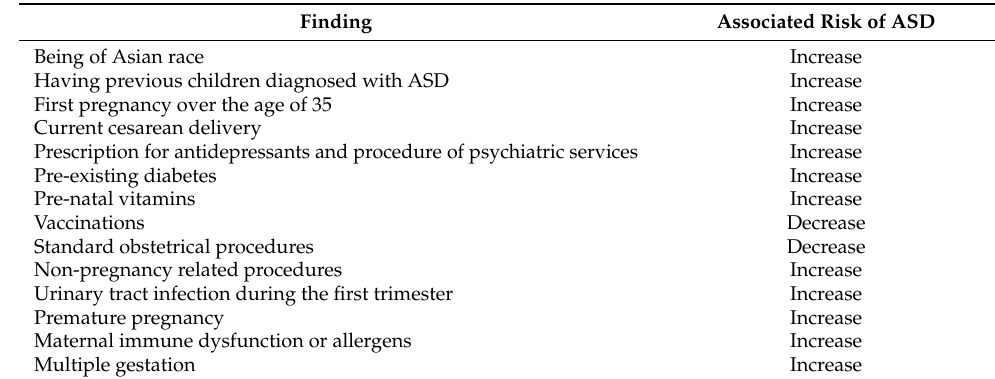
Table 9. Summary of Study